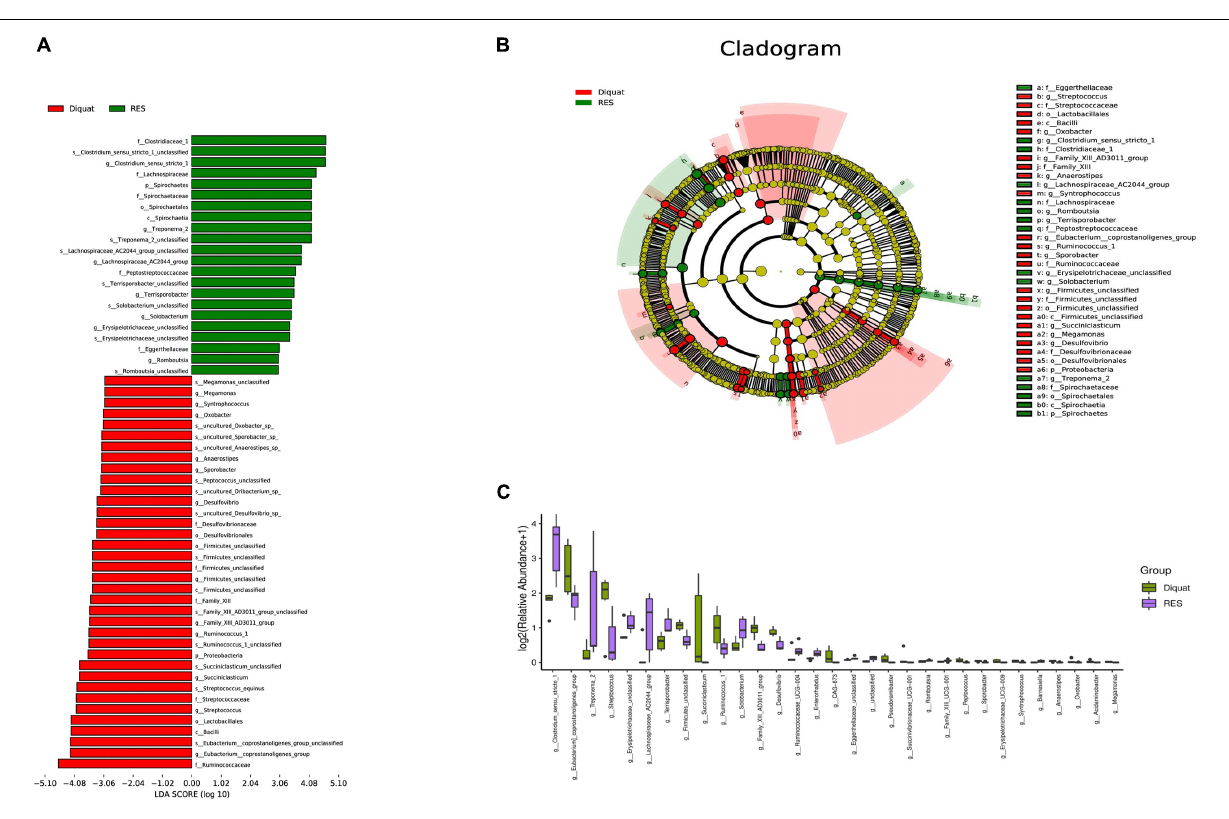
A total of 30 second-level classification Clusters of Orthologous Genes (COG) and KEGG Orthology (KO) pathways were verified based on the structure of the colon microbiota